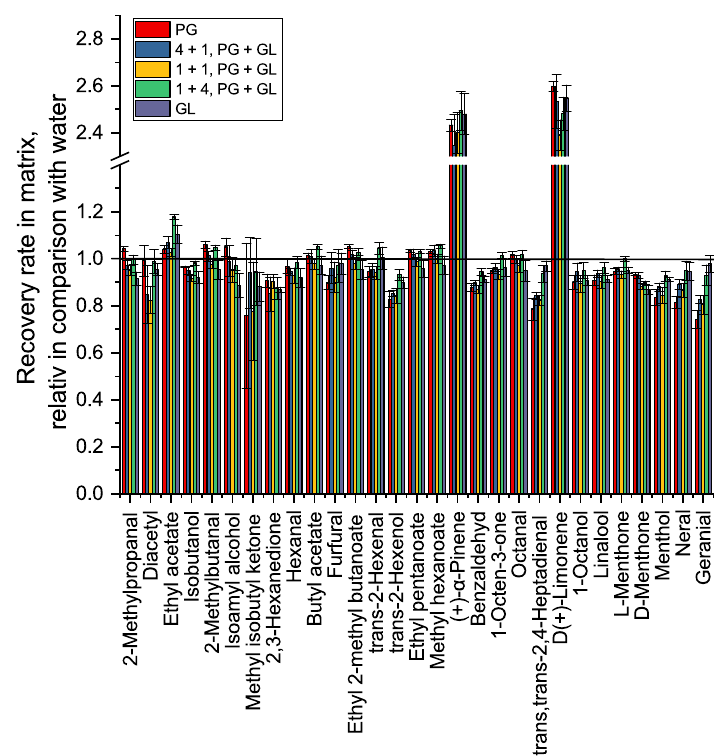
Figure A3. Ratio of signal intensity, for all analyzed analytes, in a range of possible matrices consisting of propylene glycol and glycerol, compared to in water for spiked samples of 5 µgg matrix and quadruplicate